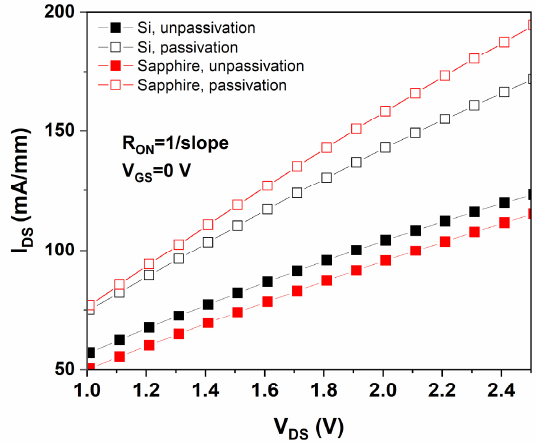
Figure 5. Plot showing the linear regime of I DS versus V DS curves at V GS = 0 V for determining the dynamic on resistance of AlGaN/GaN HEMTs on Si and sapphire substrates without and with SiO 2 passivation.